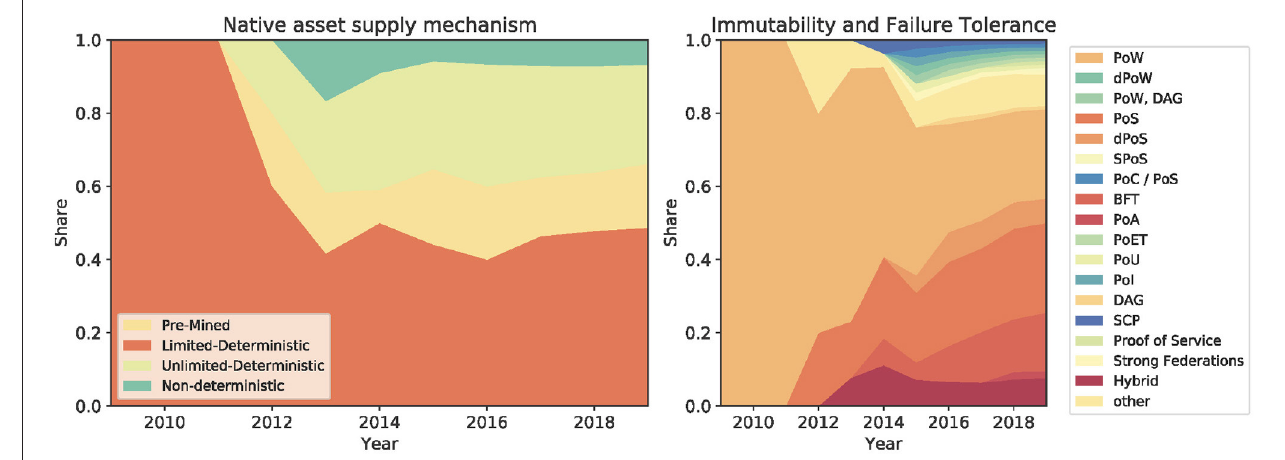
FIGURE 4 | New supply and consensus mechanisms have emerged over time.